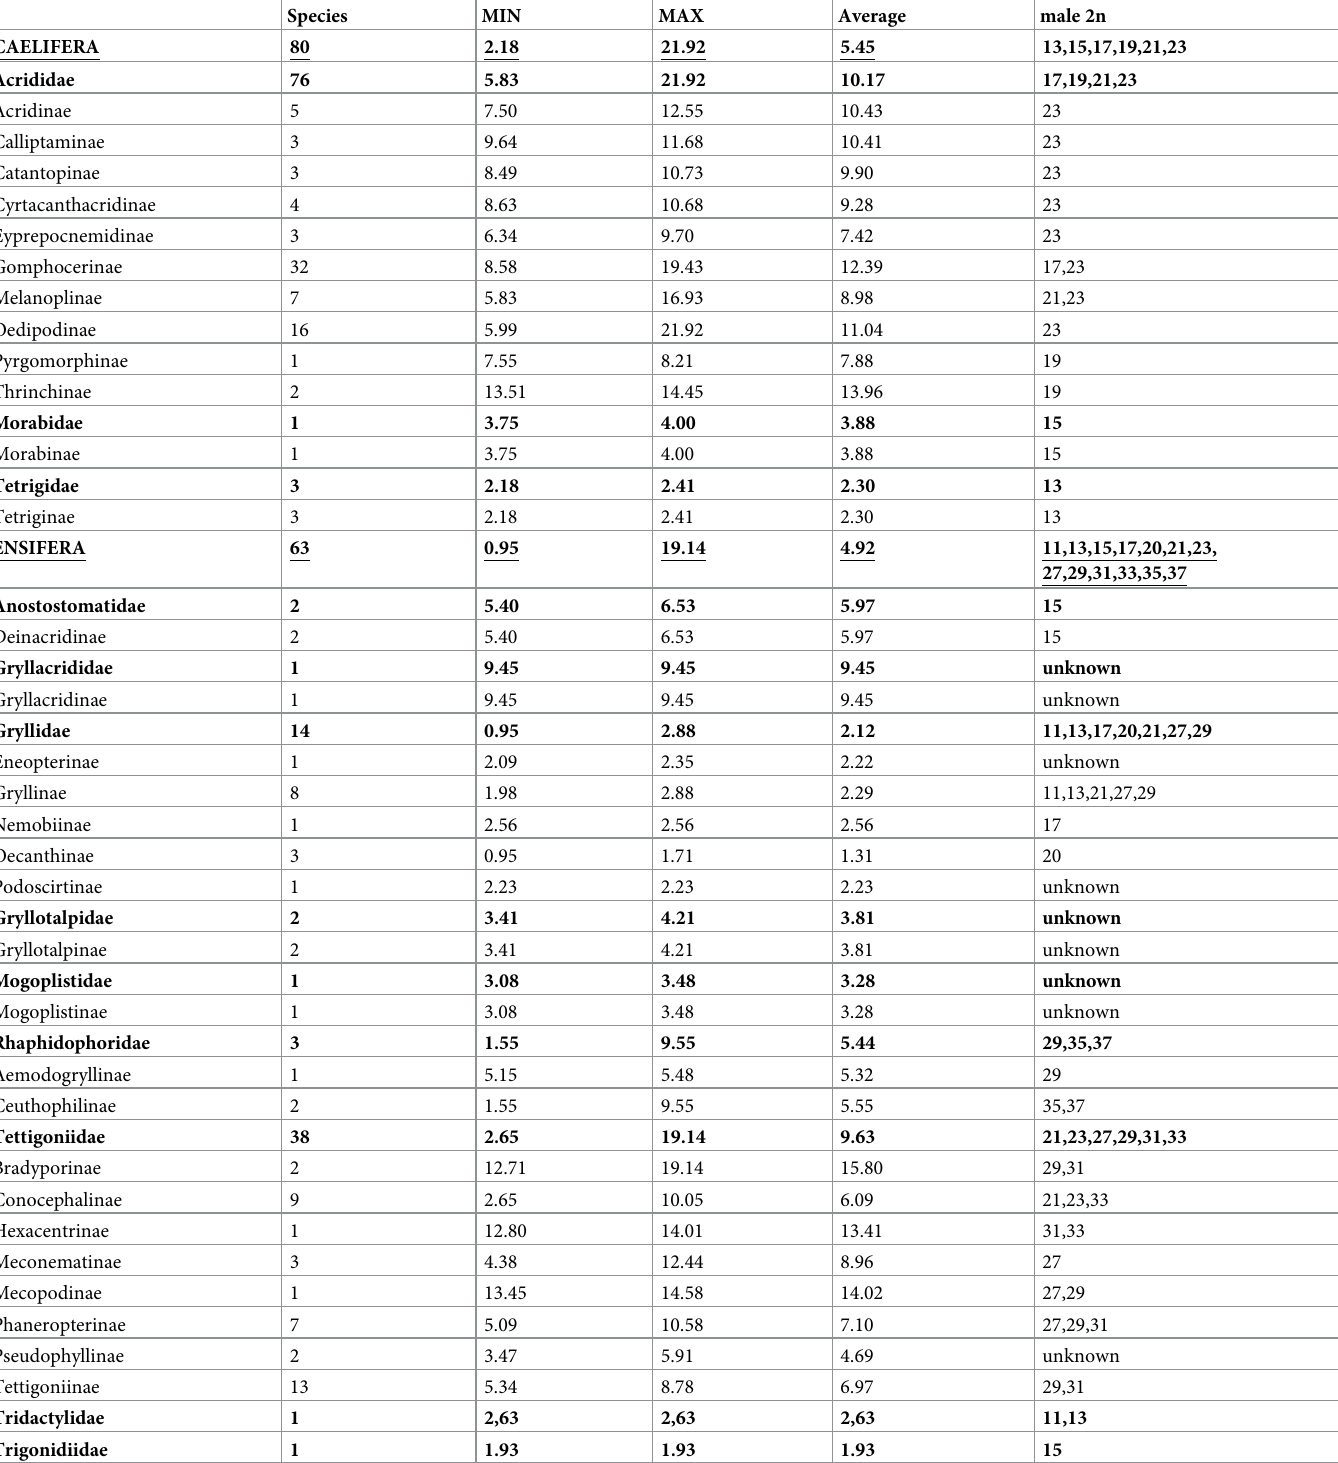
Table 2. An overview comparison of approximate genome sizes (1C) of Orthoptera families and subfamilies analyzed so far. Species MIN MAX Average male